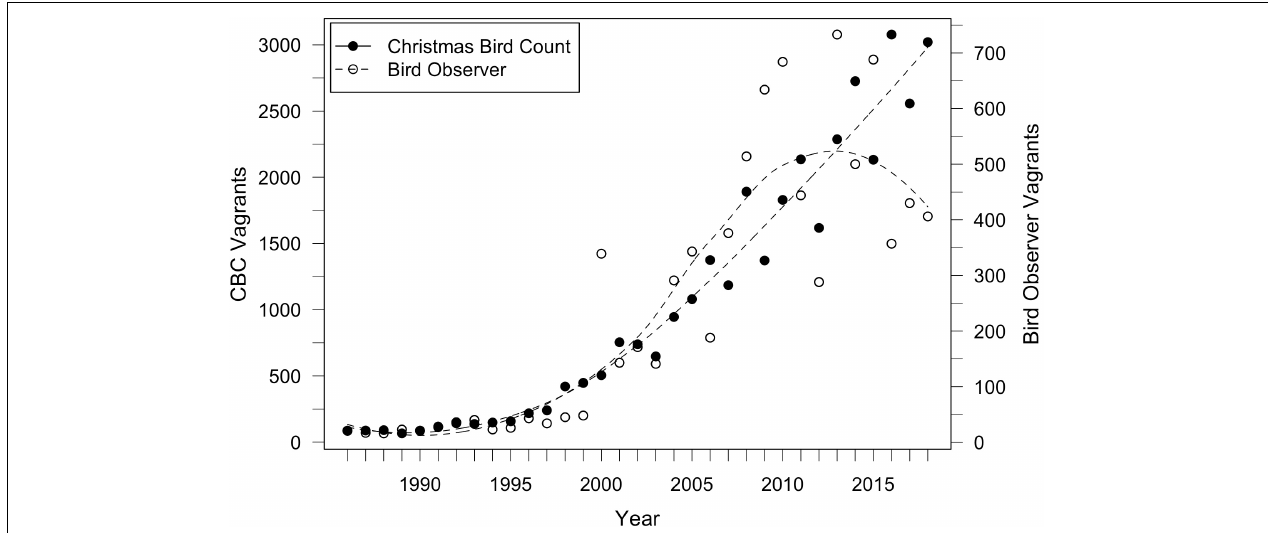
FIGURE 3 | Records of individual LBBG seen in North America during yearly Christmas Bird Counts (CBC) and from Bird Observer records from 1986 to 2018. LBBG sightings increased rapidly after the early 1990s, and in the last decade, over 1,000 individuals have been present each year. CBC and Bird Observer records are positively correlated with each other ( r = 0.82, p <